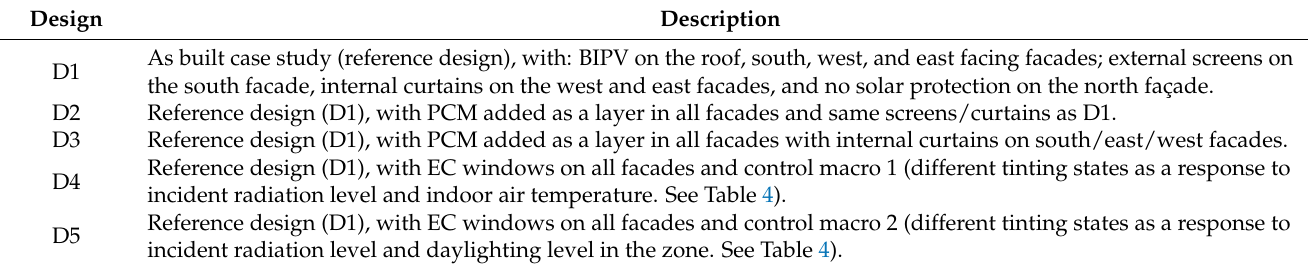
Table 3. Details of the five designs considered in the case study